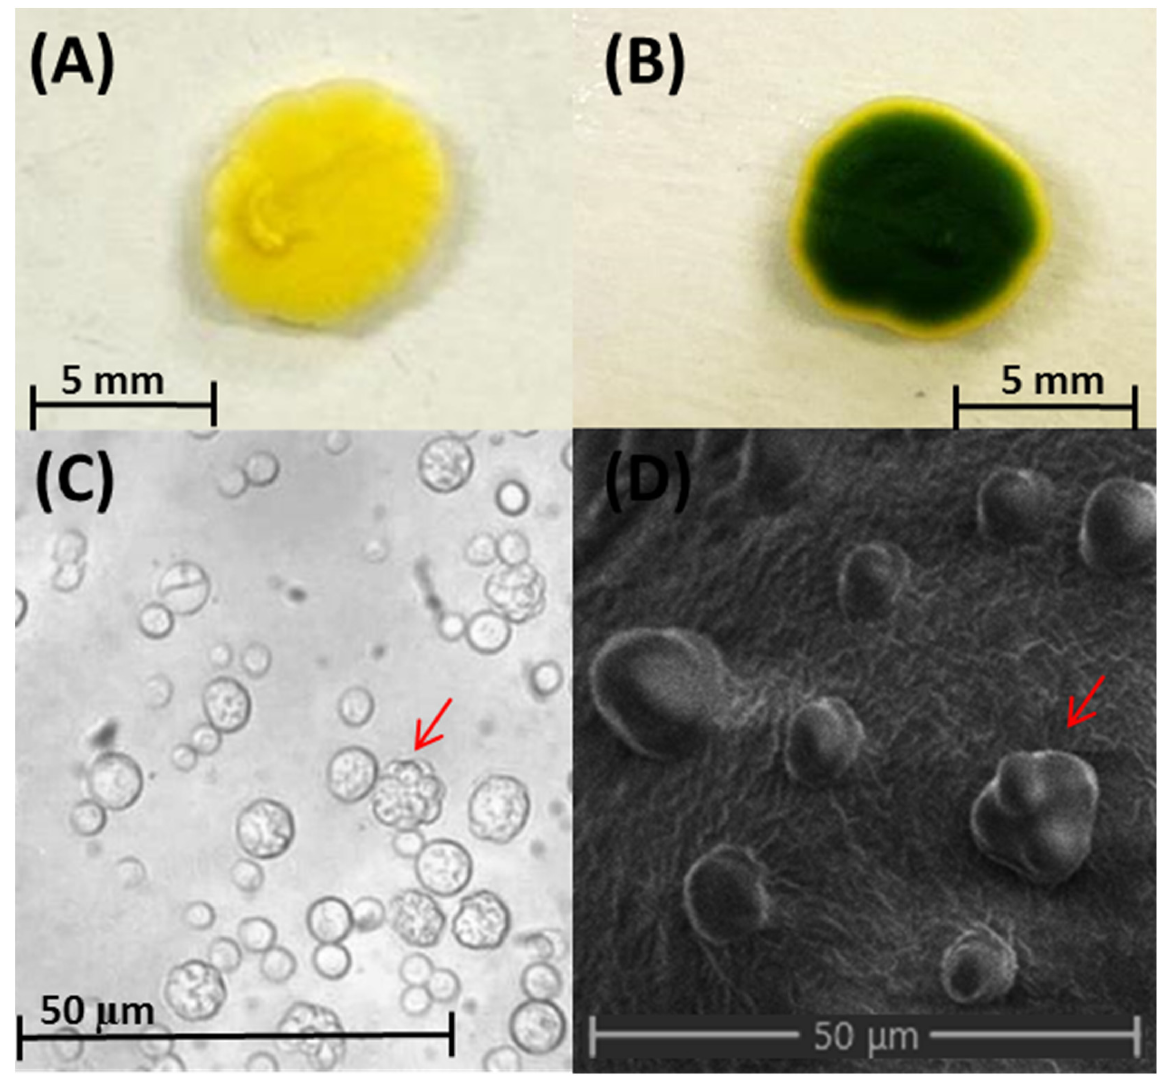
Figure 2. Colony and cell morphology of the C. vulgaris strain isolated from soil. ( A ) A colony grown in the dark. ( B ) A colony grown under natural sunlight. ( C ) Cells imaged under an optical microscope at 400×. ( D ) Cells imaged under a scanning electron microscope. The red arrows in ( C ) and ( D ) indicate the autospores inside the autosporangium. The cells were cultivated in potato dextrose broth (for microscopy) or potato dextrose agar (for colony viewing).